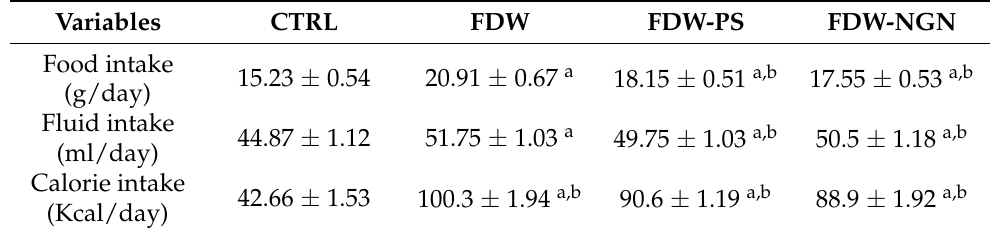
Table 1. Effects of fructose, Piper sarmentosum , and naringin on physiological variables of all groups over 12